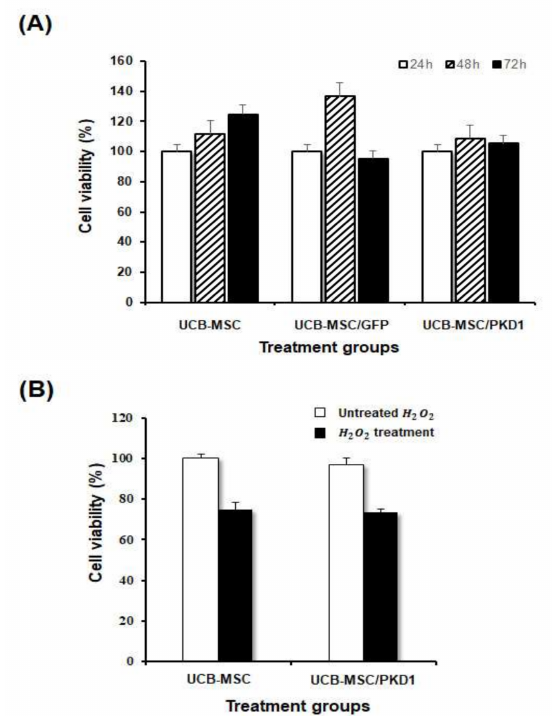
Figure 3. Biological effects of PKD1 in UCB-MSC. To assess the biological function of PKD1 in PKD1 -expressing UCB-MSC, PKD1 vector was transfected, and then after 48 h, cell proliferation and antioxidant effect were examined. ( A ) Cell proliferation in a cultured time-dependent manner by MTT assay; ( B ) The resistance effect against oxidative stress induced by H 2 O 2 . Data shown represent the mean ± SD ( n =